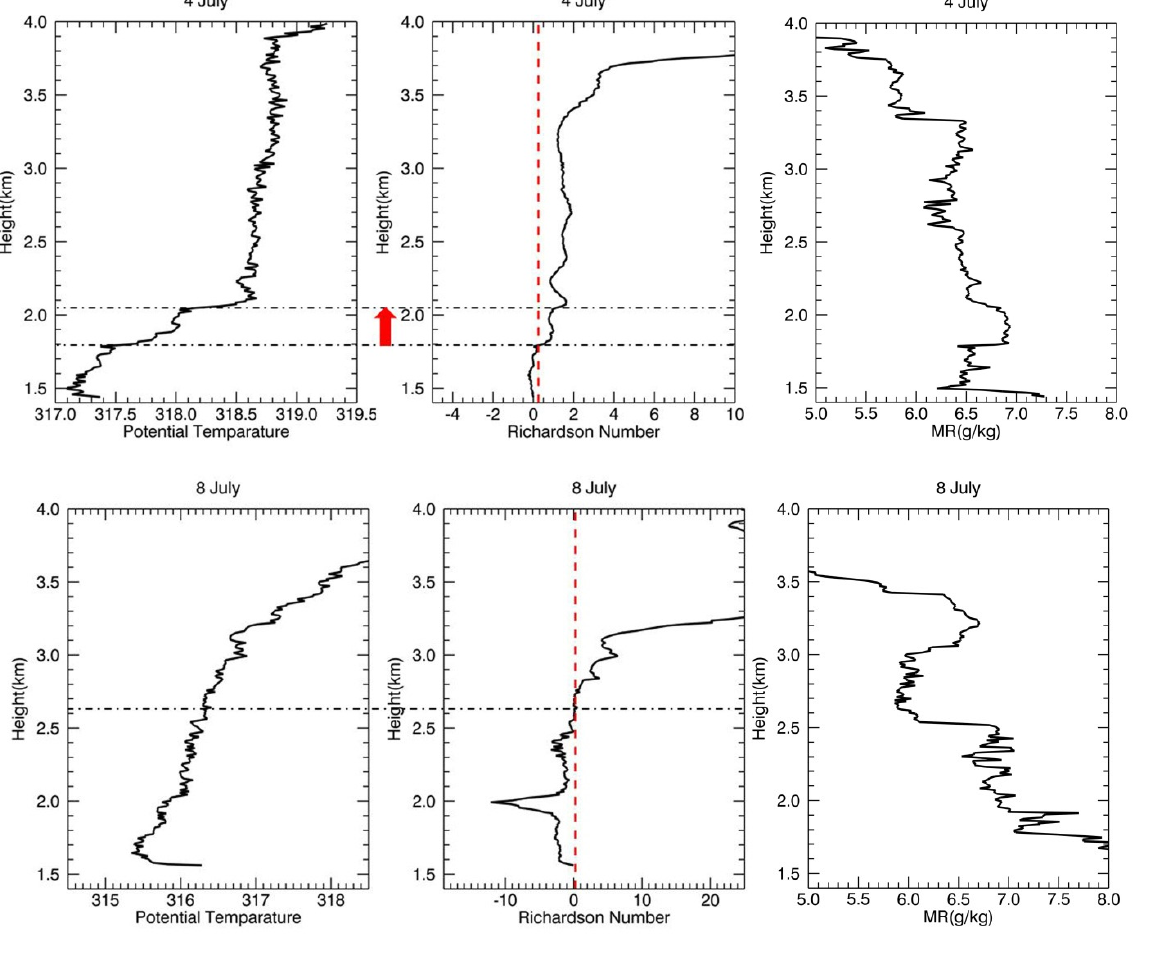
Figure 4. Profile of potential temperature, MR and Richardson number calculated from radiosonde data collected at Gaoya station on 4 July and Wuxing station on 8 July,